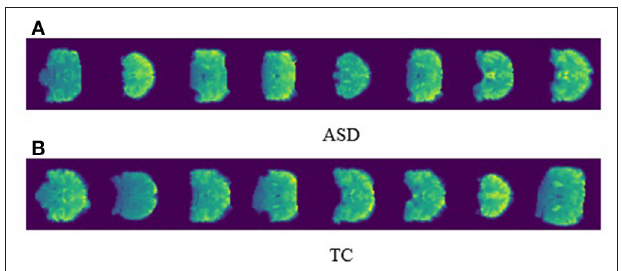
FIGURE 4 | The visualization of single sliced ASD and TC